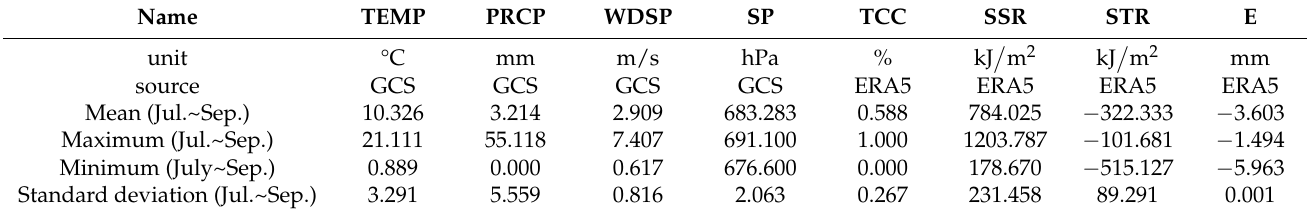
Table 2. Data sources and attributes of relevant meteorological data.